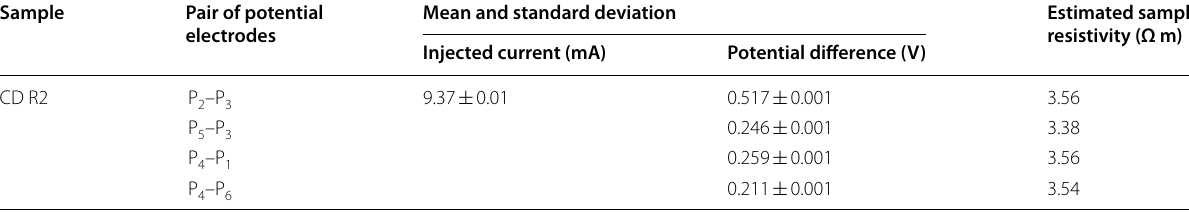
Table 6 Measurement results for the low-resistivity plastic sample (CD R2) Sample